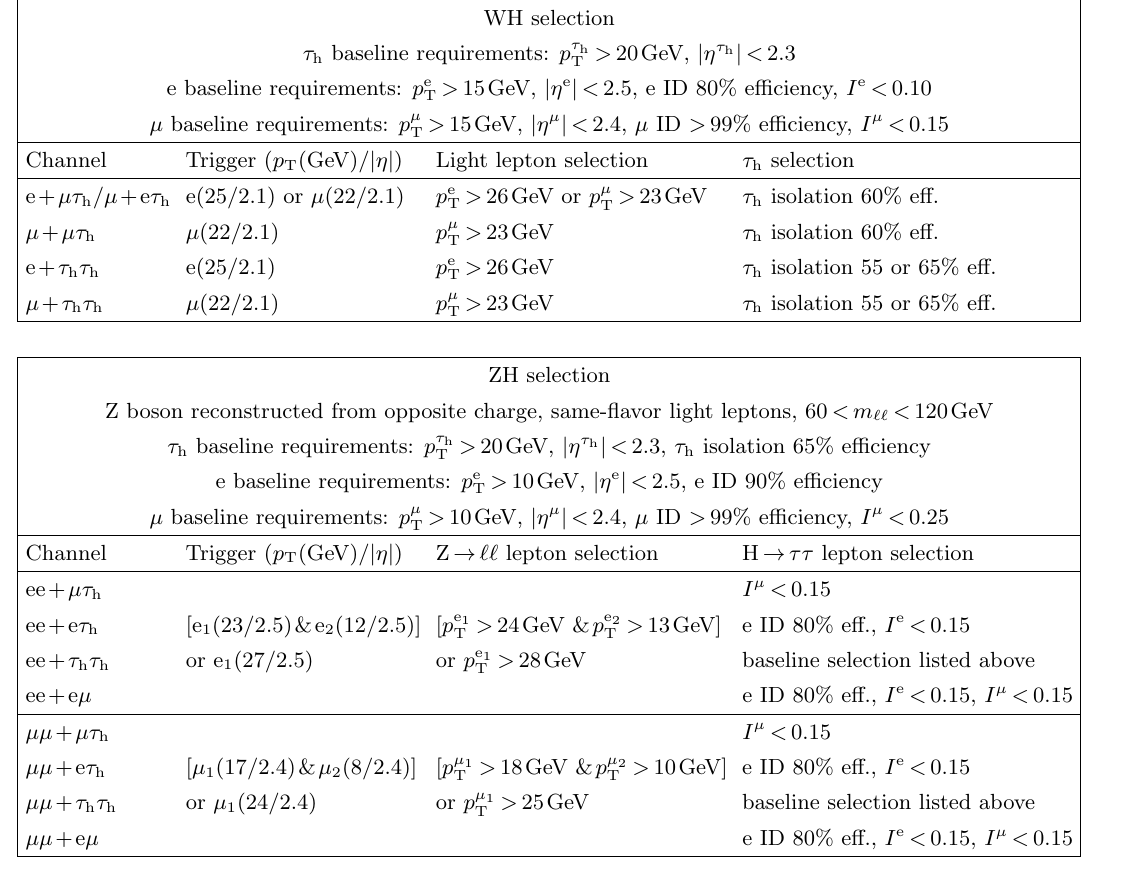
Table 1 . Kinematic selection requirements for WH and ZH events. The trigger requirement is de(cid:12)ned by a combination of trigger candidates with p T over a given threshold (in GeV), indicated inside parentheses. The j (cid:17) j thresholds come from trigger and object reconstruction constraints. ZH events are selected with either a lower p T threshold double lepton trigger or a higher p T threshold single lepton